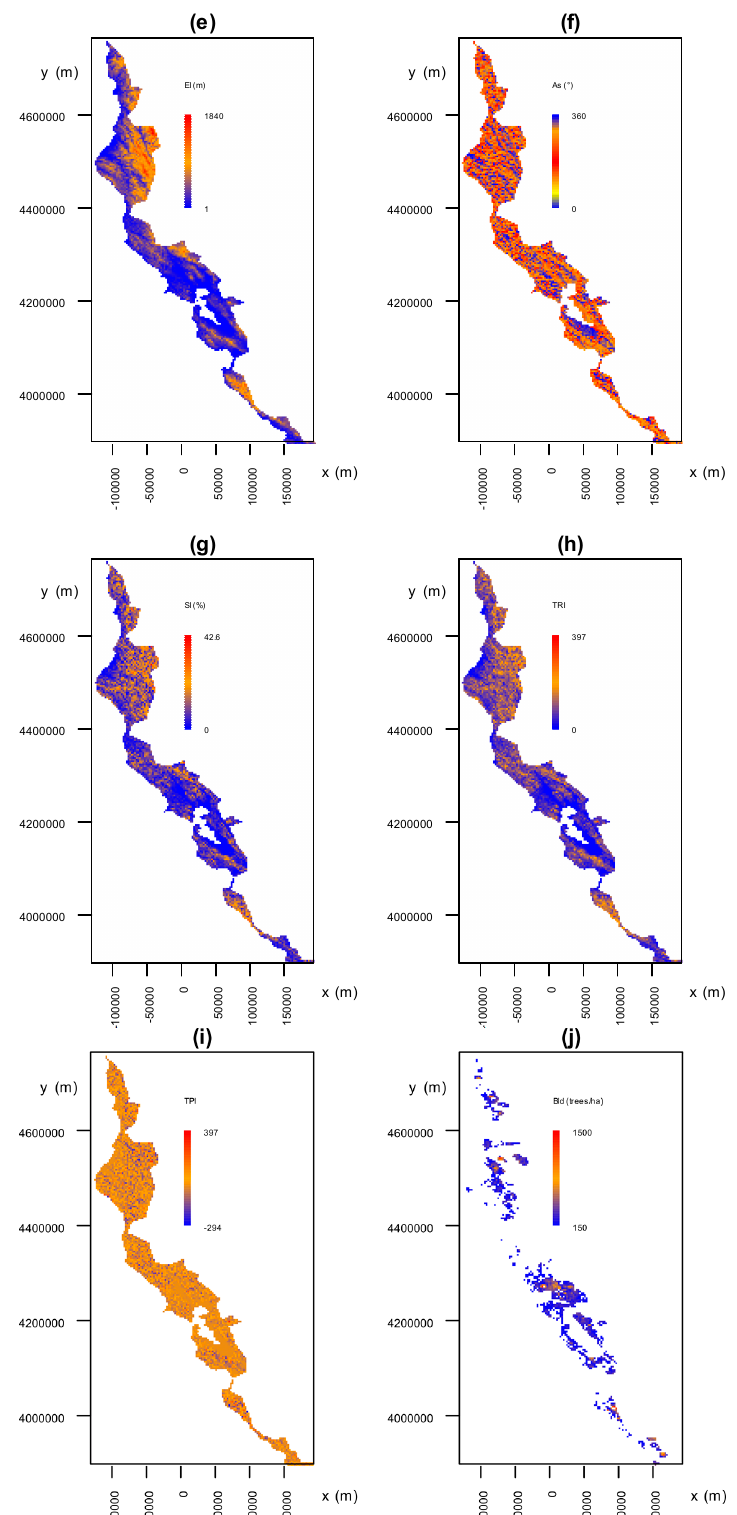
Figure 4. Raster maps of the environmental factors across the study area. Each panel refers to a specific factor: ( a ) T min ; ( b ) T max ; ( c ) T mean ; ( d ) P; ( e ) El; ( f ) As; ( g ) Sl; ( h ) TRI; ( i ) TPI and ( j ) Bld. Along with coordinates, the unit of measurement and the range are reported for each factor. A color gradient from blue to red shows the transition between low and high values of the factor, with the exception of As, where colors represent transitions between contiguous cardinal points (N—blue, E—yellow, S—red, W—orange). Coordinates are in UTM NAD83 zone 11N (EPSG 4326). For factors acronyms, see the main text.